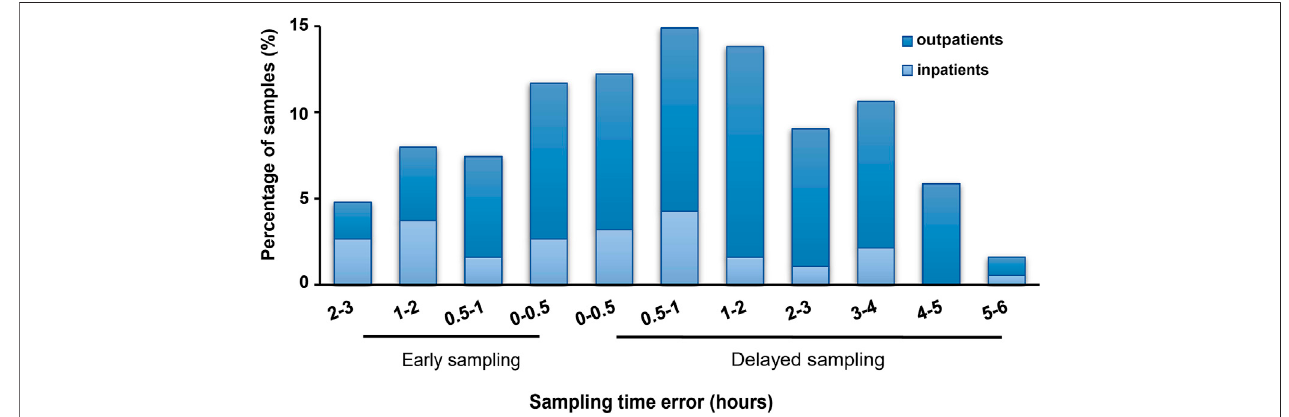
FIGURE 3 | Sampling time deviation induced concentration error (A, B) and relative concentration error (C, D) of tacrolimus.